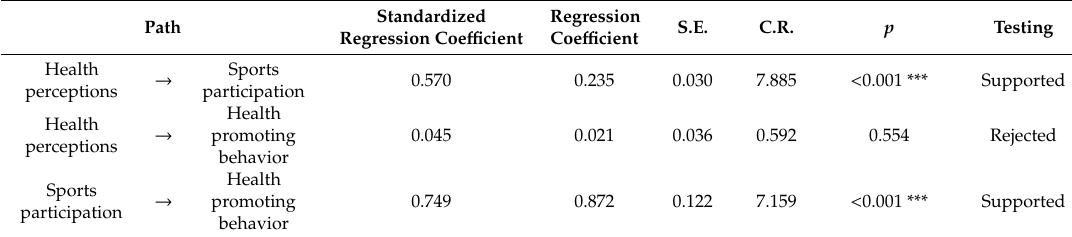
Table 8. Path analysis results.